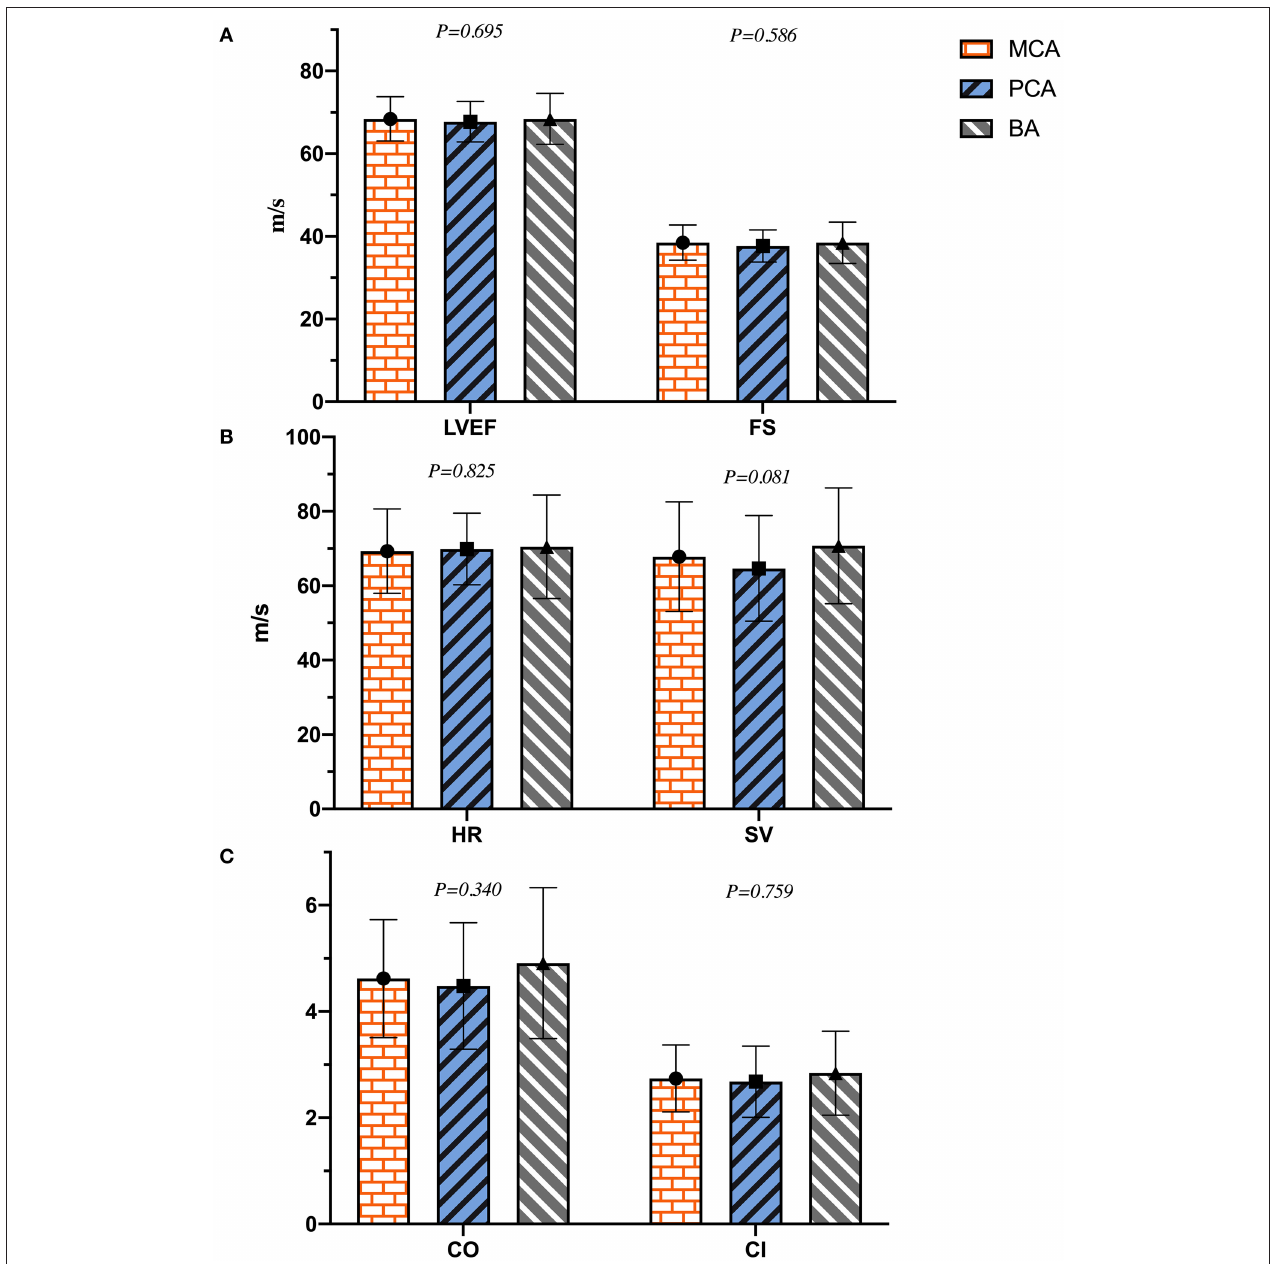
FIGURE 5 | The plot of (A–C) indicated the difference of left ventricular systolic function in different cerebral artery